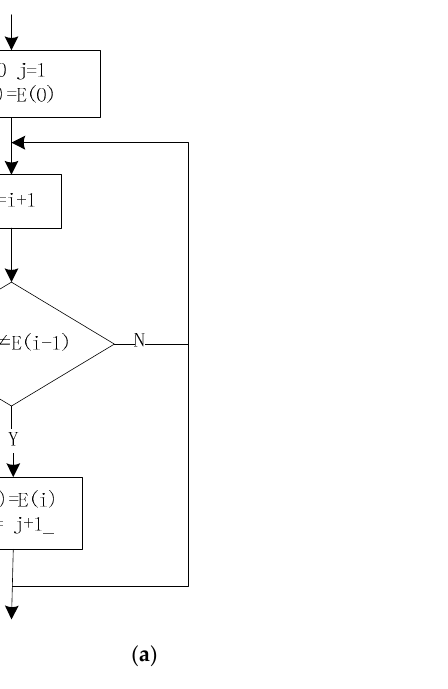
( f ) Figure 9. Rain flow matrix of load on the standard road. ( a ) Rain flow matrix of F x on the left WFS, ( b ) Rain flow matrix of F y on the left WFS, ( c ) Rain flow matrix of F z on the left WFS, ( d ) Rain flow matrix of F x on the right WFS, ( e ) Rain flow matrix of F y on the right WFS, ( f ) Rain flow matrix of F z on the right WFS.